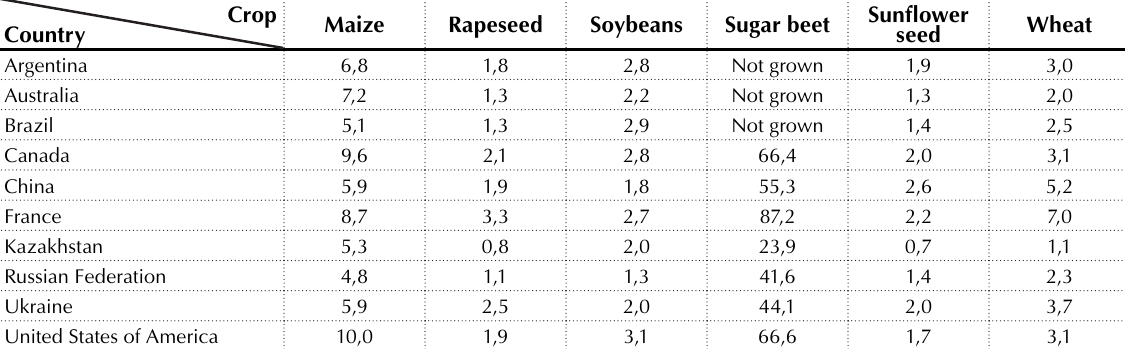
Source: Developed by the authors using FAOSTAT.